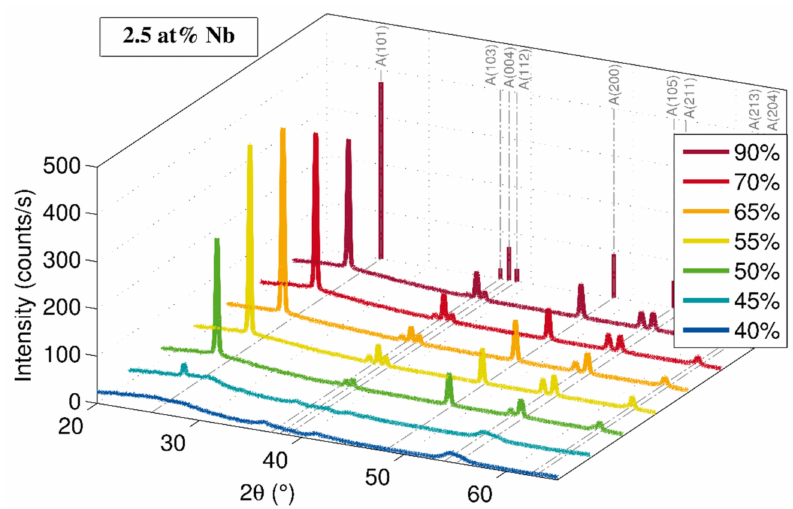
Figure 5. XRD pattern of TiO 2 − x films doped with 2.5 at% Nb sputtered at different O 2PP . All films were about 250 nm thick, capped, annealed at 300 ◦ C for 2 h and measured in grazing incidence geometry. All evolving reflexes belong to the anatase phase (powder pattern is illustrated by the dashed lines and at the back wall of the 3D plot). Capped films sputtered with O 2PP values below 55% stay amorphous even when annealed at higher temperatures of up to 500 ◦